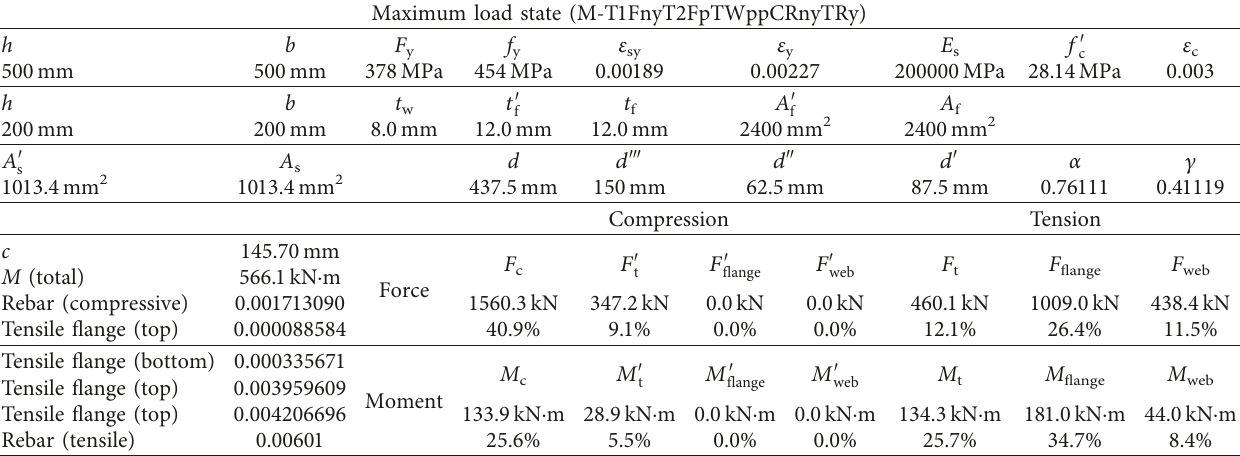
Table 5: Flexural moment capacity at the maximum load state (Specimen #3) [19].